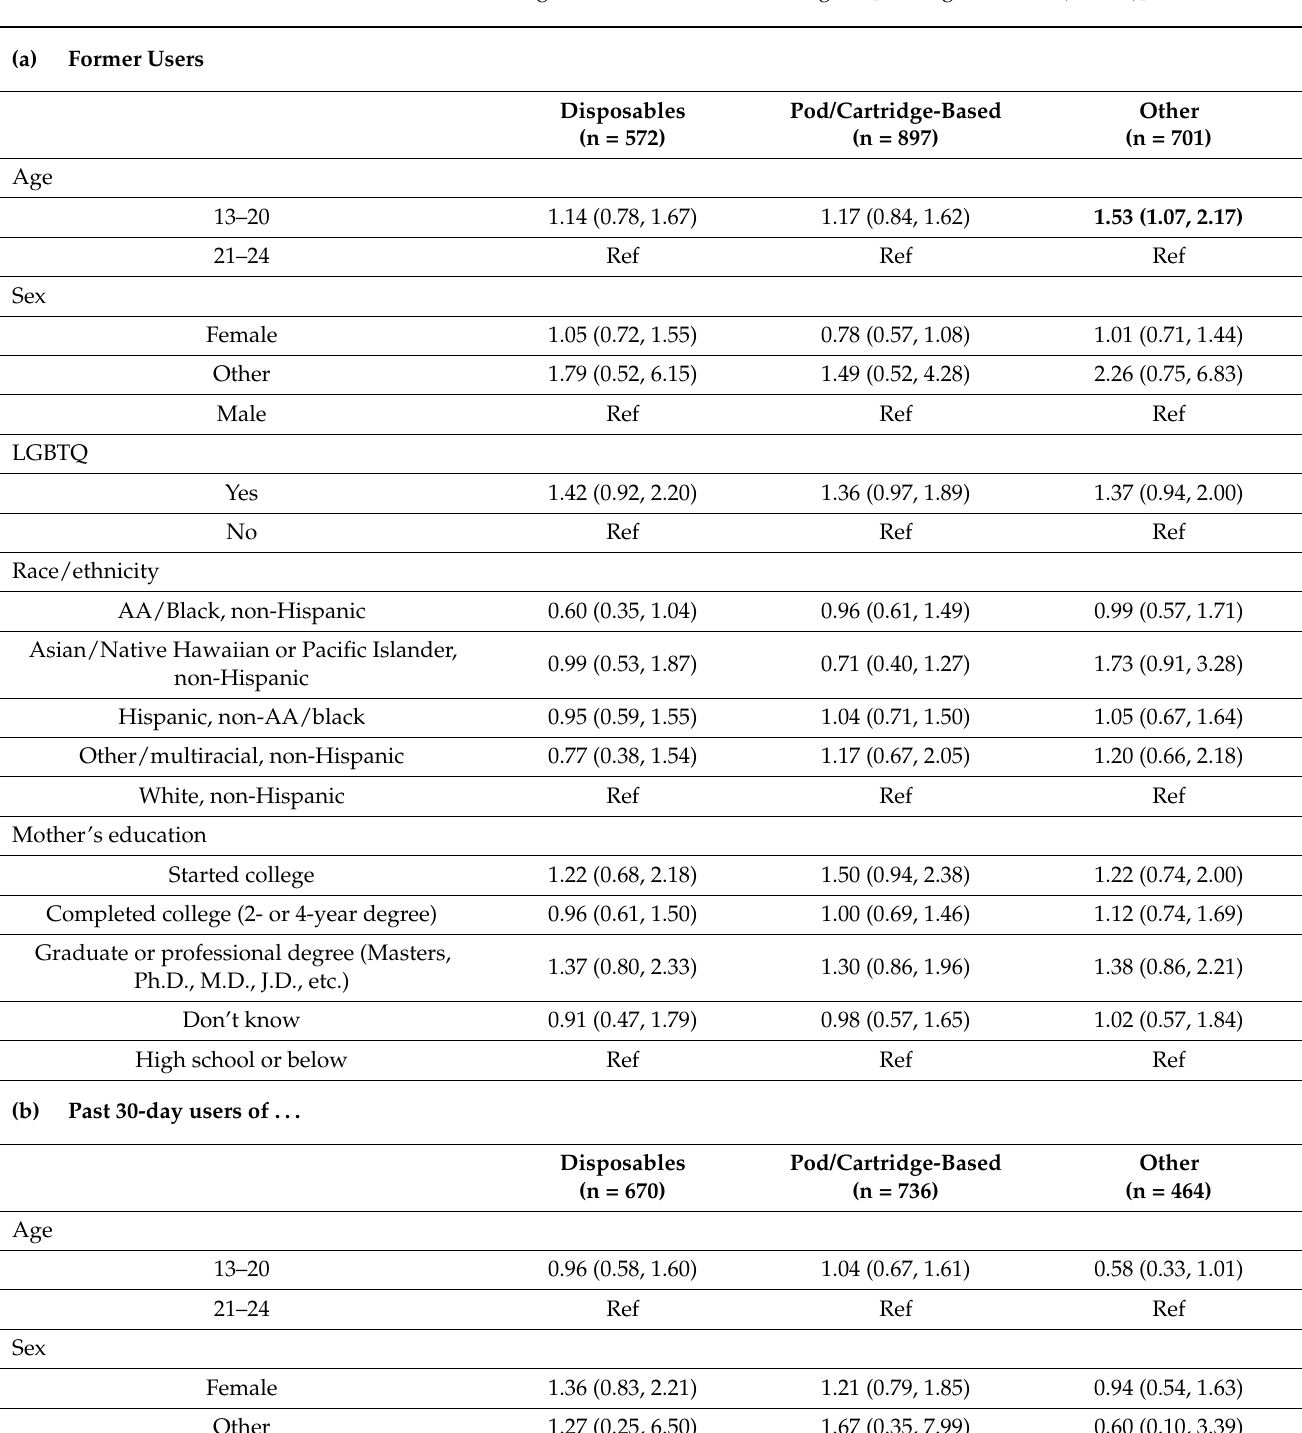
Table 3. Odds of using in the next 6 months among . . . [unweighted AOR (95%CI)]